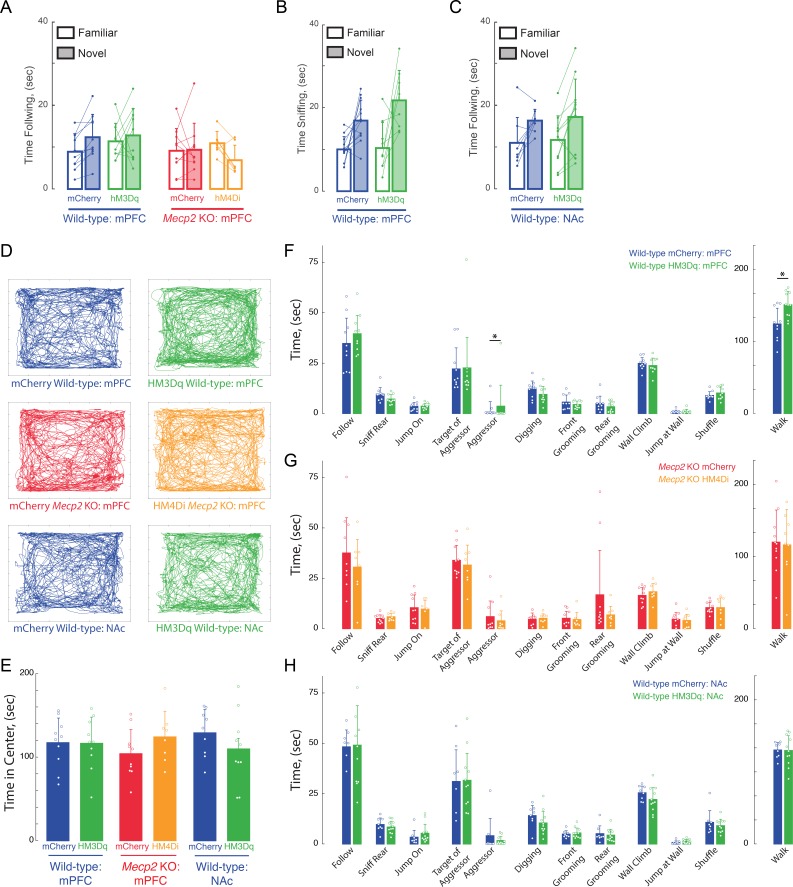
Lack of effects of Acute DREADD stimulation by CNO on anxiety and general (non-social memory) behaviors.(A and C) Total times spent following novel vs.familiar sentinels in DREADDs expressed in mPFC-projecting vHIP neurons (A) or NAc-Projecting vHIP neurons (C). (B) Total times spent for sniffing novel vs. familiar objects in DREADDs expressed in mPFC-projecting vHIP neurons. (D) Representative tracks of individual trajectories of test mice during social encounters in an open field. (E) Average time spent in the center of the open field, as a measure of anxiety (mCherry mPFC vs. mPFC hM3Dq WT, p>0.9999; mCherry mPFC WT vs. Mecp2 KO, p=0.9937; hM3Dq WT mPFC vs. mCherry mPFC Mecp2 KO, p=0.9718; mCherry vs. hM4Di mPFC Mecp2 KO, p=0.8502; hM4Di mPFC Mecp2 KO vs. mCherry mPFC WT, p=0.9916; One-Way ANOVA). (F–H) Time spent engaging in social, aggressive, general, and locomotor behaviors during the unrestricted social interaction assay in (F) vHIP-mPFC DREADD-expressing WT mice, (G) and vHIP-mPFC Mecp2 KO mice (n = 10 vHIP-mPFC mCherry WT mice; n = 10 vHIP-mPFC hM3Dq WT mice; n = 11 vHIP-mPFC mCherry Mecp2 KO; n = 8 vHIP-mPFC hM4Di Mecp2 KO mice). (H) Time spent engaging in social, aggressive, general, and locomotor behaviors during the unrestricted social interaction assay in DREADD-expressing vHIP-NAc WT mice after acute CNO treatment (n = 8 vHIP-NAc mCherry WT mice; n = 10 vHIP-NAc hM3Dq WT mice; mCherry NAc vs. mCherry mPFC WT, p=0.9492; mCherry vs. hM3Dq NAc WT, p=0.9952; hM3Dq NAc WT vs. mCherry mPFC WT, p=0.9982; hM3Dq NAc WT vs. mCherry mPFC Mecp2 KO, p=0.9009; Student’s t-test or Mann-Whitney Test dependent on Normalcy). Mean ± SD; *p<0.05, **p<0.01.10.7554/eLife.44182.030Figure 5—figure supplement 1—source data 1.Acute manipulation of activity of vHIP-mPFC projection neurons regulates social memory in a task- and projection-specific manner.